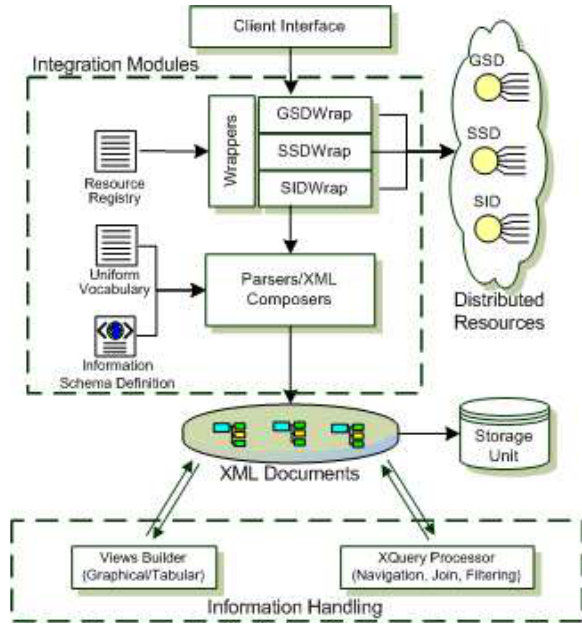
Figure 1: Schematic view of the architecture’s structural and functional